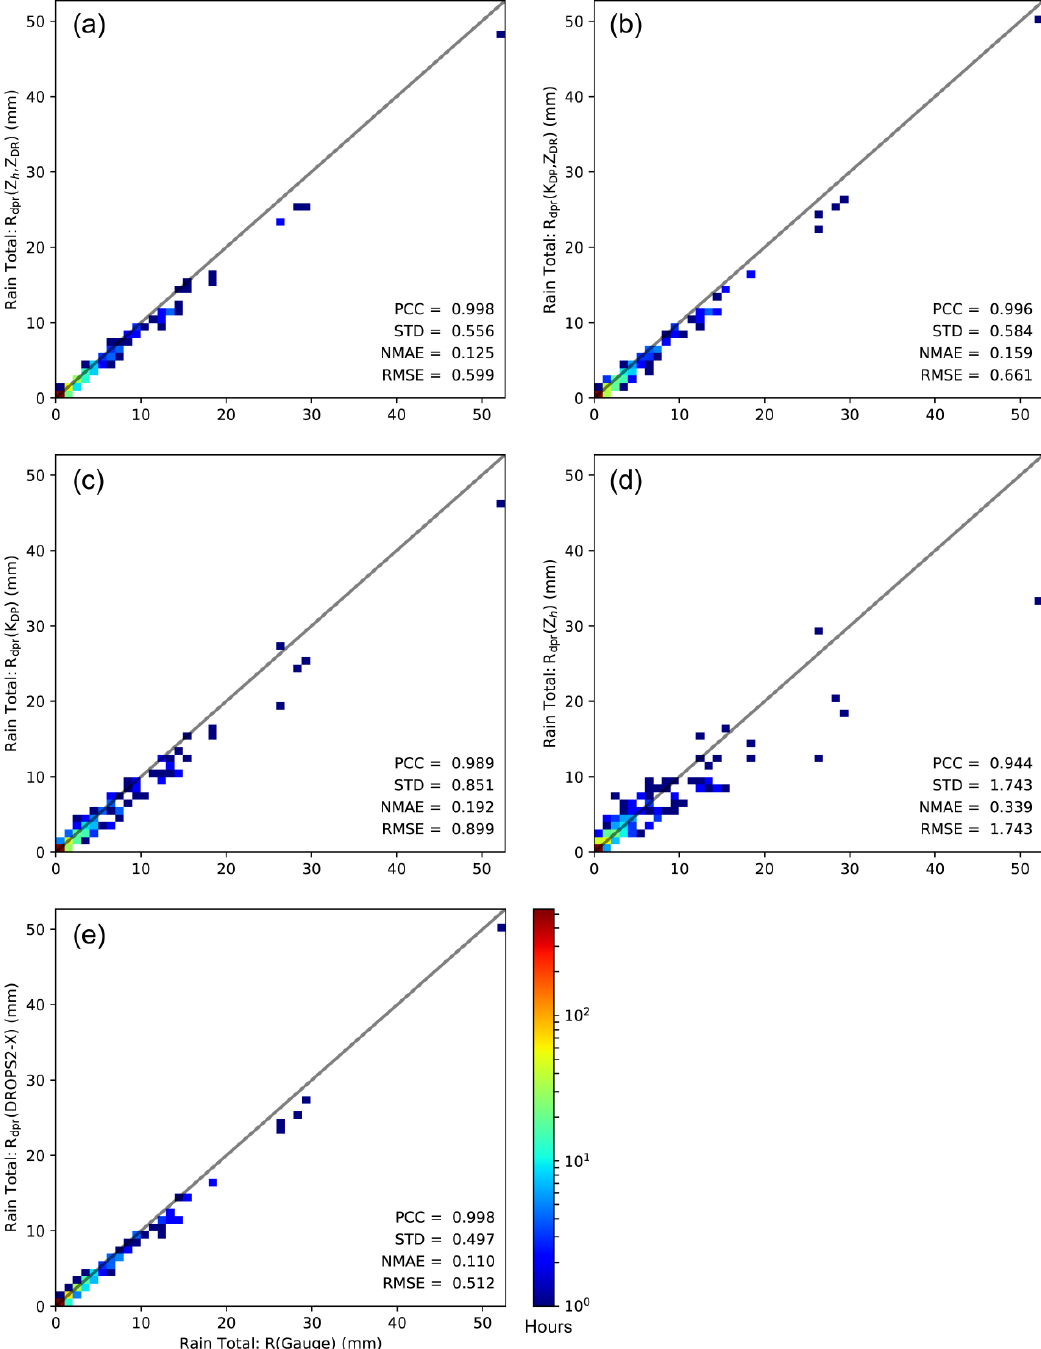
Figure 11. Scattergram (based on the total rainfall observations) of hourly rainfall estimates (mm) from various radar rainfall relations vs. rain gauge measurements: ( a ) R dpr ( Z h , Z DR ) , ( b ) R dpr ( K DP , Z DR ) , ( c ) R dpr ( K DP ) , ( d ) R dpr ( Z h ) , and ( e ) R dpr ( DROPS2–X ) . The grey diagonal straight line in each panel represents the 1–1 relationship. The quantitative evaluation results are also indicated in each panel, including the Pearson correlation coe ffi cient (PCC), standard deviation (STD—mm), normalized mean absolute error (NMAE), and root-mean-square error (RMSE — mm).